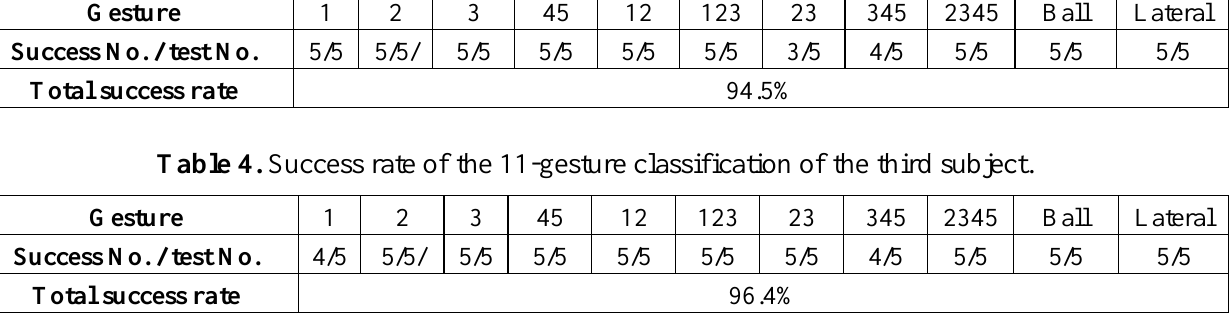
Table 3. Success rate of the 11-gesture classification of the second subject. Gesture